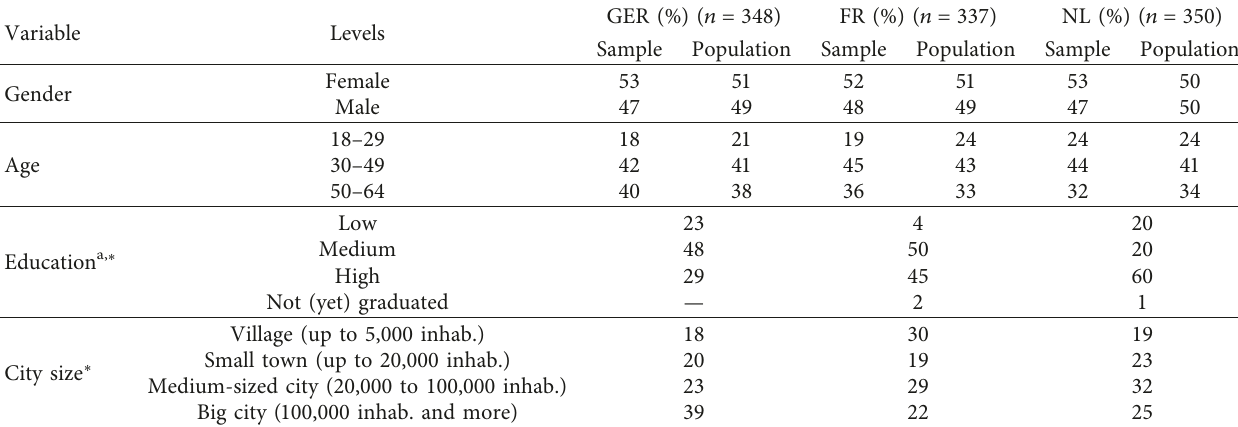
Table 2: Sample characteristics ( n